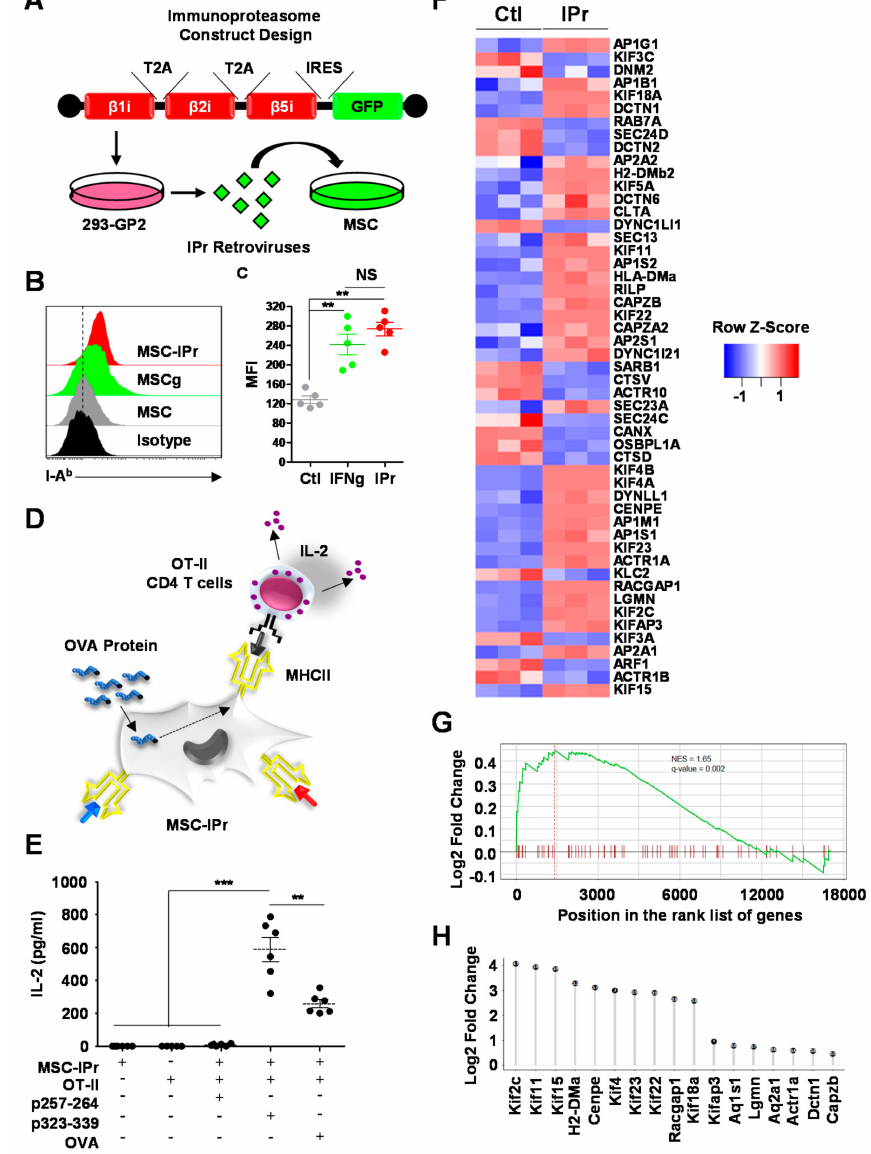
Figure 1. Characterizing the antigen presentation capacity of antigen-pulsed MSC-IPr to CD4 T cells. ( A ) Representative schematic diagram showing MSC-IPr engineering. ( B , C ) Representative flow cytometry assessment of MHCII expression ( B ) and its mean fluorescent intensity (MFI-C). Ctl MSCs are shown in grey, MSC γ in green and MSC-IPr in red. Isotype staining is shown in black. ( D ) Schematic diagram showing the antigen presentation assay used to evaluate the